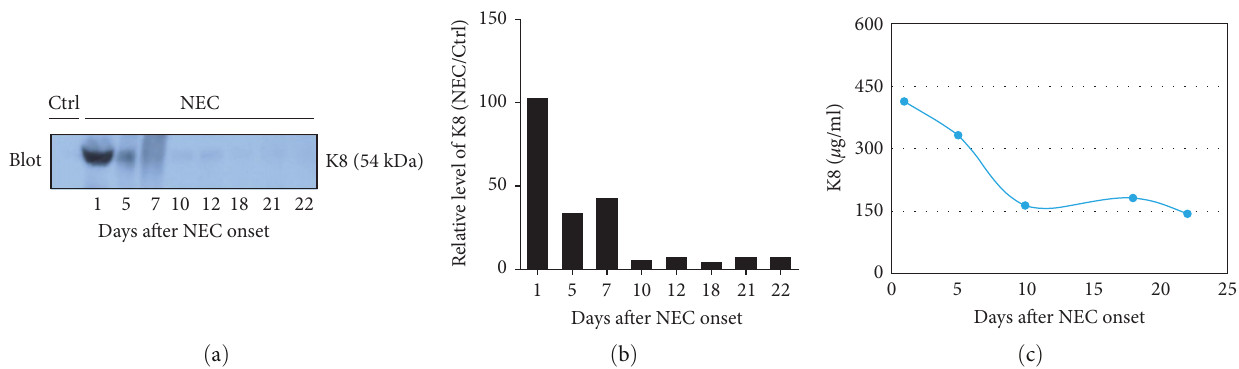
F IGURE 3: Time course of serial fecal K8 levels in an NEC neonate: (a) fecal K8 levels were detected using Western blot. Fecal K8 from a non- NEC neonate (one from the Ctrl1 group) was used as a Ctrl; (b) quanti fi cation of blots was made using ImageJ program; (c) fecal K8 levels were detected using a modi fi ed ELISA protocol. The results showed that the K8 level is highest on the fi rst day after NEC onset. One week later, it declined to one-third of the initial level, and then persisted at a very low level from the tenth day after NEC onset. Note that fecal K8 is a potential biomarker for NEC diagnosis or monitoring the effectiveness of clinical resolution.